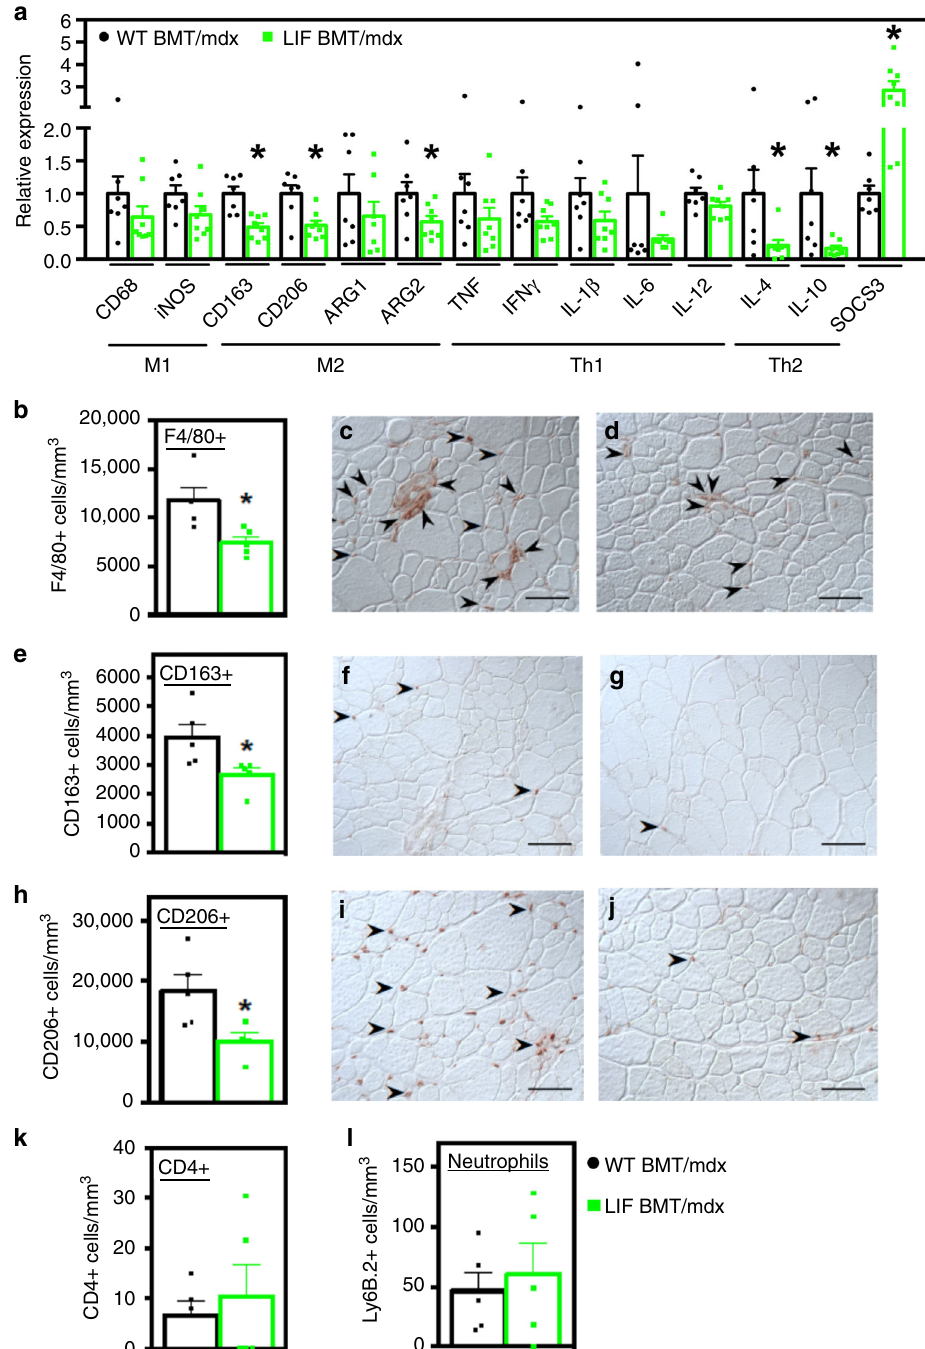
Fig. 3 Transplantation of CD11b/LIF transgenic BMCs into mdx mice reduces in fl ammation in dystrophic muscle. a QPCR analysis shows that the transplantation of CD11b/LIF transgenic BMCs into mdx recipients (LIF BMT/ mdx ) reduced expression of transcripts associated with M2-biased macrophages ( Cd163 , Cd206 , and Arg2 ), Th2 cytokines ( Il4 and Il10 ), and increased expression of the negative regulator of cytokine signaling ( Socs3) compared to WT BMT mdx recipients (WT BMT/ mdx ) 4 months post-transplantation. N = 7 or 8 for WT BMT/ mdx and LIF BMT/ mdx data sets, respectively, except n = 7 for LIF BMT/ mdx Arg1 data set. * Indicates signi fi cantly different from WT BMT/ mdx recipients at P < 0.05. F -test Ifng ( P = 0.0145), Il6 ( P < 0.0001), Il4 ( P = 0.0015), Il10 ( P < 0.0001), and Socs3 ( P = 0.0061). For all histograms in the fi gure, the bars indicate mean ± sem. b – j Cross-sections of TA muscles from WT BMT/ mdx ( c , f , i ) or LIF BMT/ mdx ( d , g , j ) mice were immunolabeled with antibodies to F4/80 ( c , d ), CD163 ( f , g